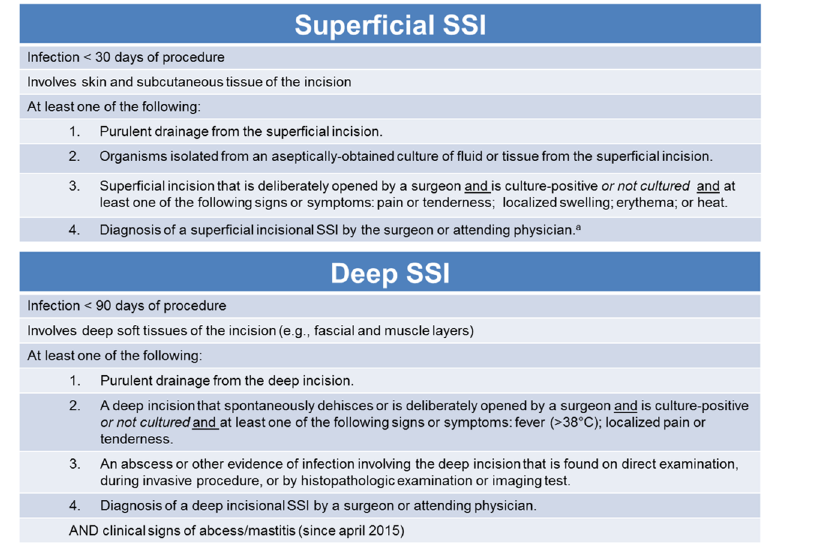
Fig 2. Patient flowchart (CONSORT).